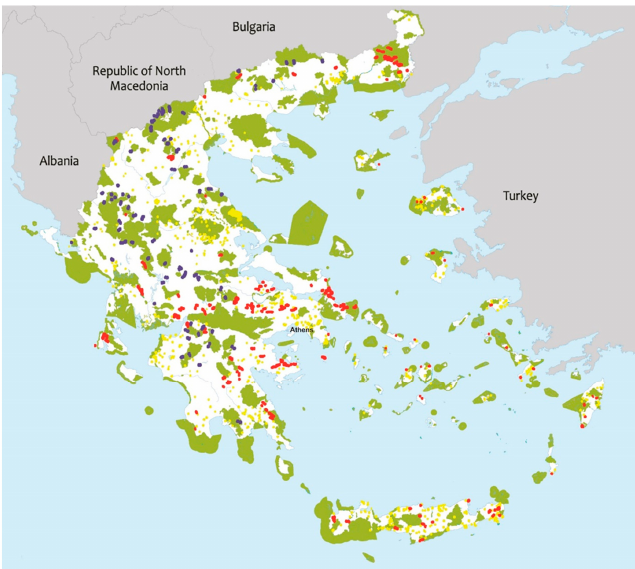
Figure 1. Map of Greece, featuring the Natura 2000 network, as well as existing renewable energy projects. Green: protected areas under the European Commission Habitats Directive and/or the EU Directive on the Conservation of Wild Birds; red: wind power plants; yellow: solar photovoltaic plants; blue: small hydro